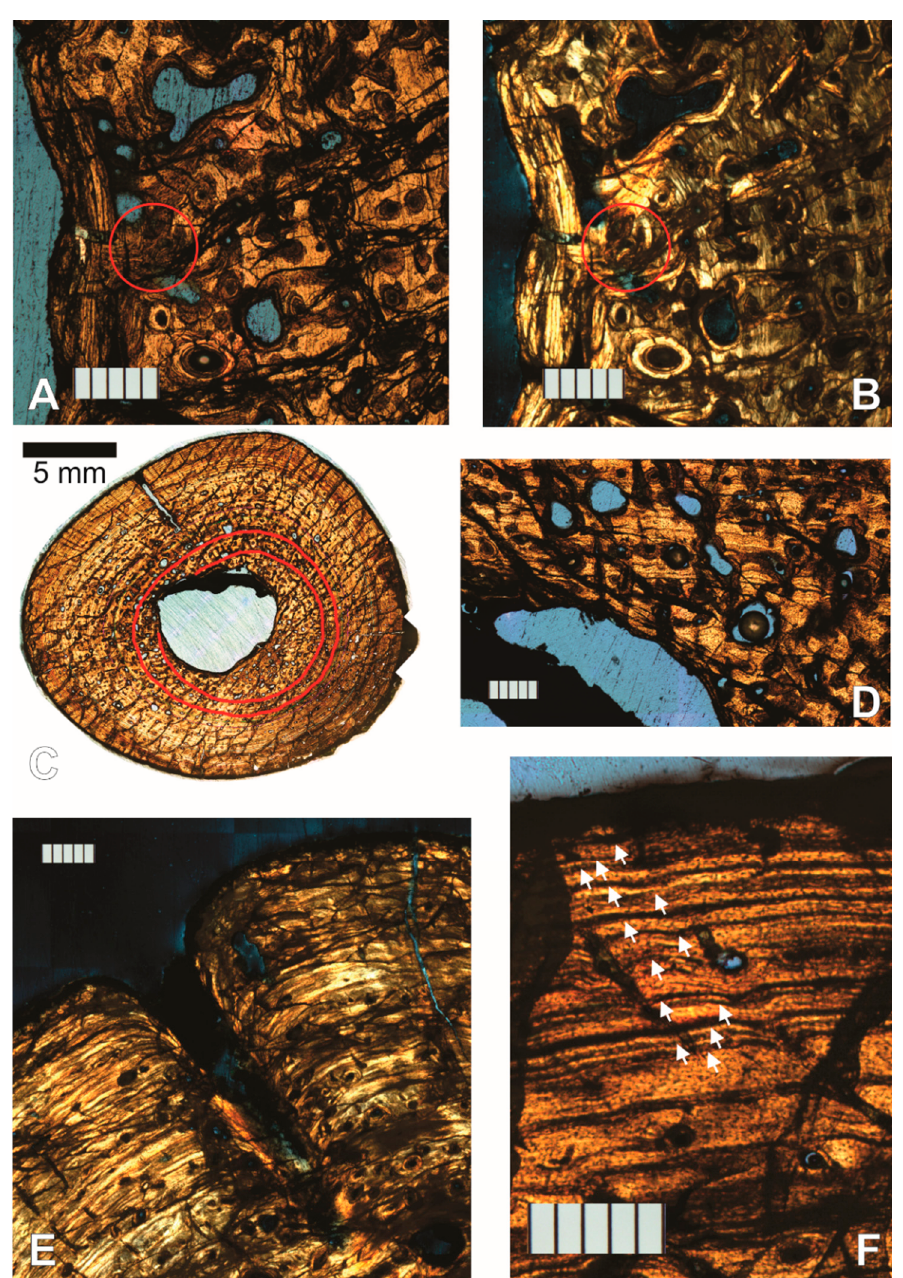
Figure 6. Additional images of thin sections of the left humerus of NJSM 23368, Hyposaurus rogersii . All scale bars are 500 µm, except in C, where it is 5 mm. ( A ) Posterolateral endosteal margin of slide 2 under ordinary transmitted light; ( B ) Posterolateral endosteal margin of slide 2 under CPL. The area circled has remnants of previous generations of osteons in interosteonal spaces. Secondary osteons are large and abundant, and the endosteal lamellae cut into the deep periosteal deposits, evidencing drift of the cavity; ( C ) Slide 3 under ordinary transmitted light, with two lines of arrested growth (LAGs) near the medullary cavity highlighted by a thick red line, showing the medullary cavity to be off-center, as it cuts into deposits that once contained part of the innermost marked-up cyclical growth mark (CGM). Top is anterior, right is lateral; ( D ) Endosteal lamellae clearly cut into the inner periosteal lamellae at an angle in this image from the deep anterolateral quadrant of slide 1, evidencing the growth of the medullary cavity and resorption of the deep periosteal cortical deposits. Taken under ordinary transmitted light; ( E ) Mid-diaphyseal nutrient foramen in slide 2 under CPL. Lamellae clearly bend inward along its periphery, including those at the periosteal surface. Because it is longitudinally obliquely oriented and the section is transverse, it does not appear to go through to the medullary cavity on the depicted plane. See Figure 3 for the external position of this foramen on the bone surface, in anterior view; ( F ) External fundamental system (EFS) in the left